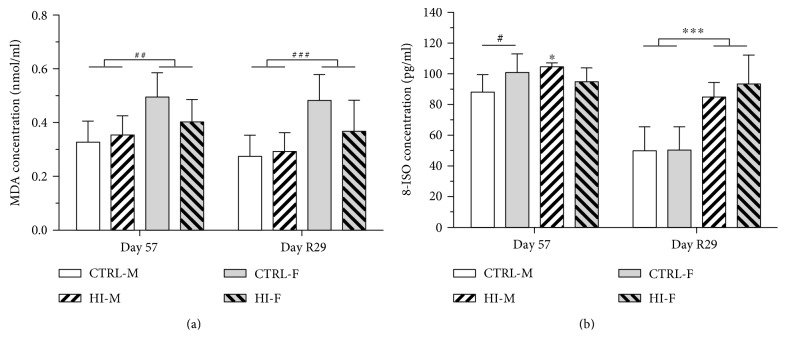
Plasma levels of lipoperoxidation products, mean + SD. (a) MDA, day 56: n = 4 − 10 and day R29: n = 5 − 10. (b) 8-ISO, day 56: n = 4 − 10 and day R29: n = 5 − 10. ∗p < 0.05 and ∗∗∗p < 0.001 for effect of HI-dosing. #p < 0.05, ##p < 0.01, and ###p < 0.001 for effect of sex.